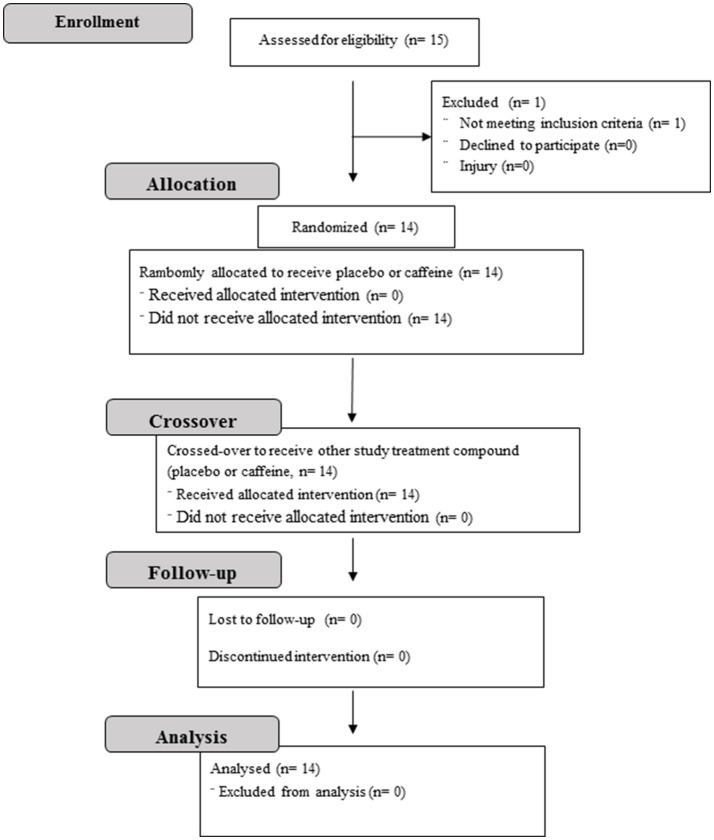
Flow diagram of the study design.